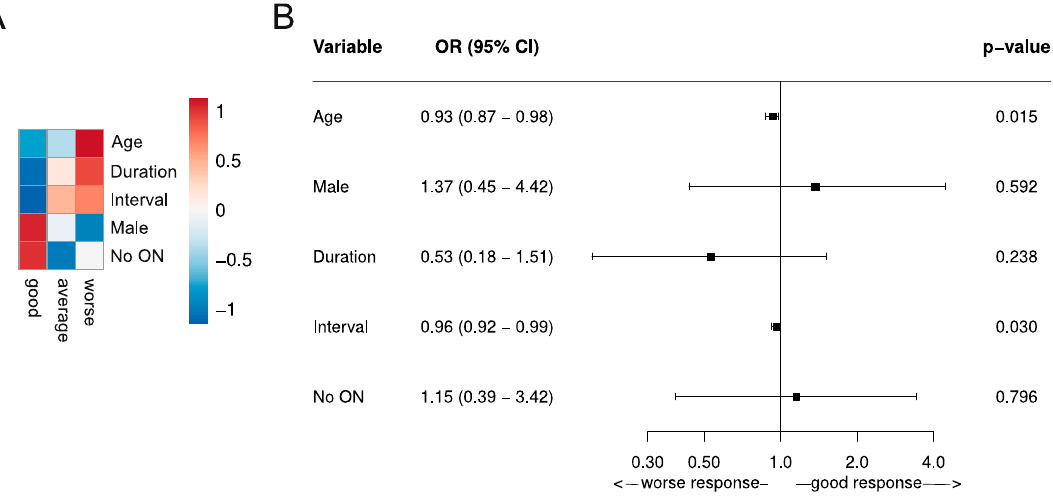
Figure 3. Predictive values of TPE response assessed by the functional systems score (FSS)-based relapse recovery model. ( A ) Predictive risk heatmap, applicable in individual patients, using three different outcome classifications (good, average, and worse) according to the Conway matrix (Figure 2) [48]. The heatmap depicts the scaled means of the variables. The red color indicates older patients (Age), with a higher prevalence of not suffering the first demyelinating event (Duration), a long interval between symptom onset and initiation of TPE (Interval), higher occurrence of male patients (Male), and a higher prevalence of relapse manifestations other than optic neuritis (no ON). ( B ) A forest plot of the predictive values of the TPE response in a multivariate logistic regression analysis. The x-axis represents the respective adjusted odd ratios for a worse versus good response. Odds ratios are outlined with a 95% confidence interval (CI; OR >1 no predictive value of treatment response, <1 statistic significant value associated with beneficial apheresis response). Data were generated in the RRMS and CIS patient cohort of five individual studies, including a total of 146 patients. All patients received TPE due to steroid unresponsive relapse [34–36,42,62].